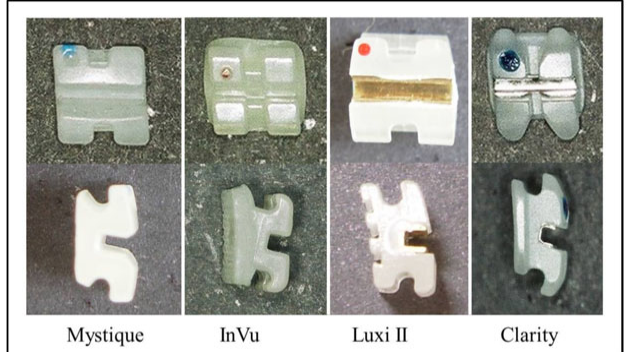
Fig. 1 – Front and side views of ceramic brackets.